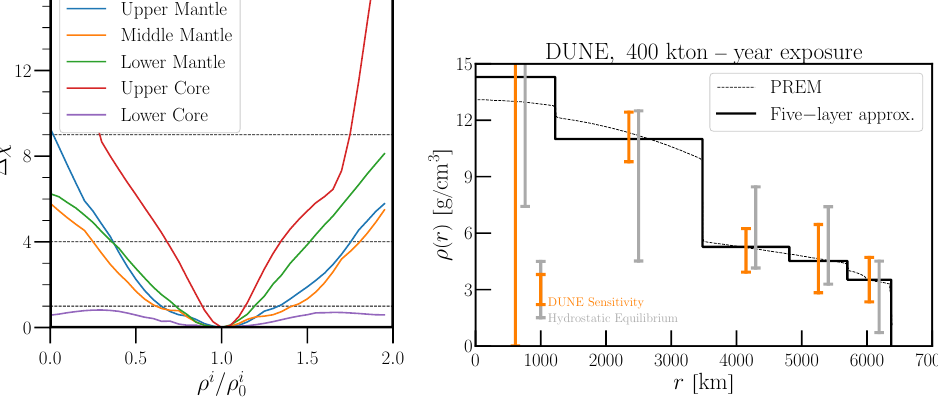
Figure 20 . Left: marginalized one-dimensional sensitivity estimates to measurements of the five layers considered in appendix A, relative to their reference values, with 400 kt-yr of exposure at DUNE. Here, constraints from the mass and inertia of the Earth are applied. Right: DUNE’s sensitivity to the Earth matter profile as a function of the radius, accounting for Earth’s total mass and moment of inertia measurements, for a 400 kton-year exposure. The gray data points show the allowed densities considering the hydrostatic equilibrium condition but no DUNE measurement, while the orange data points show the opposite, the allowed densities considering the DUNE measurement but no hydrostatic equilibrium condition. The solid black line corresponds to our 5-layer Earth model, while the PREM profile is shown for reference as a dashed